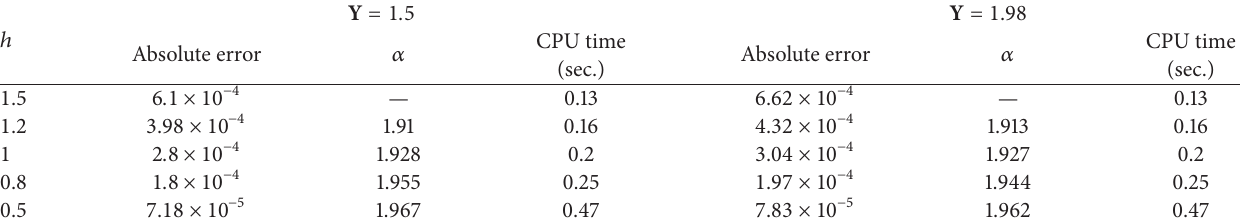
Table 4: Comparison of errors and convergence rates due to the change of ℎ for CGMY model.